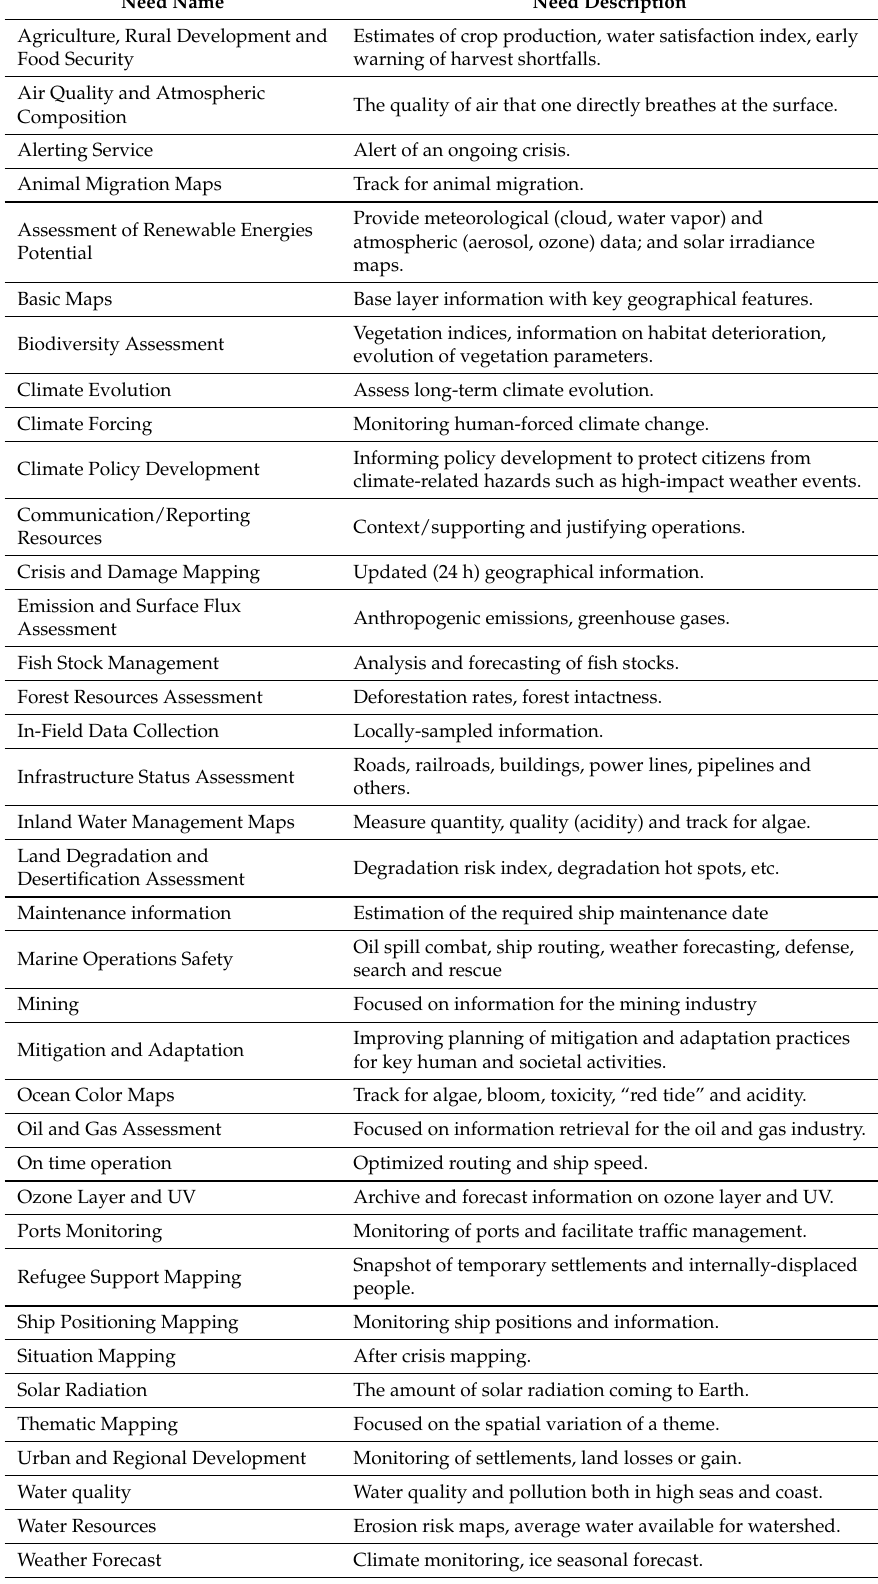
Table 1. Description of the identified user needs